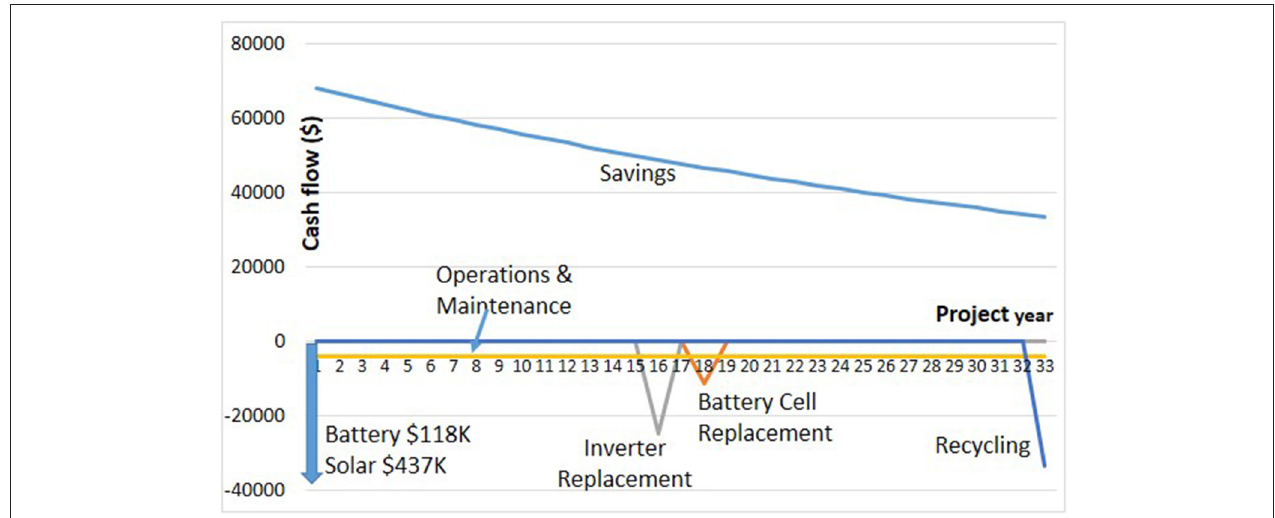
FIGURE 7 | Example 32 year cash flows for PV IRR calculation: Las Vegas, 9a.m.